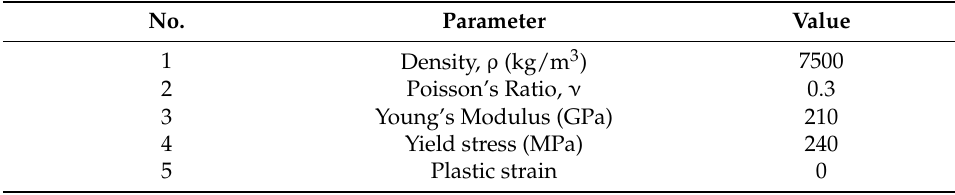
Table 2. Properties of steel used in the